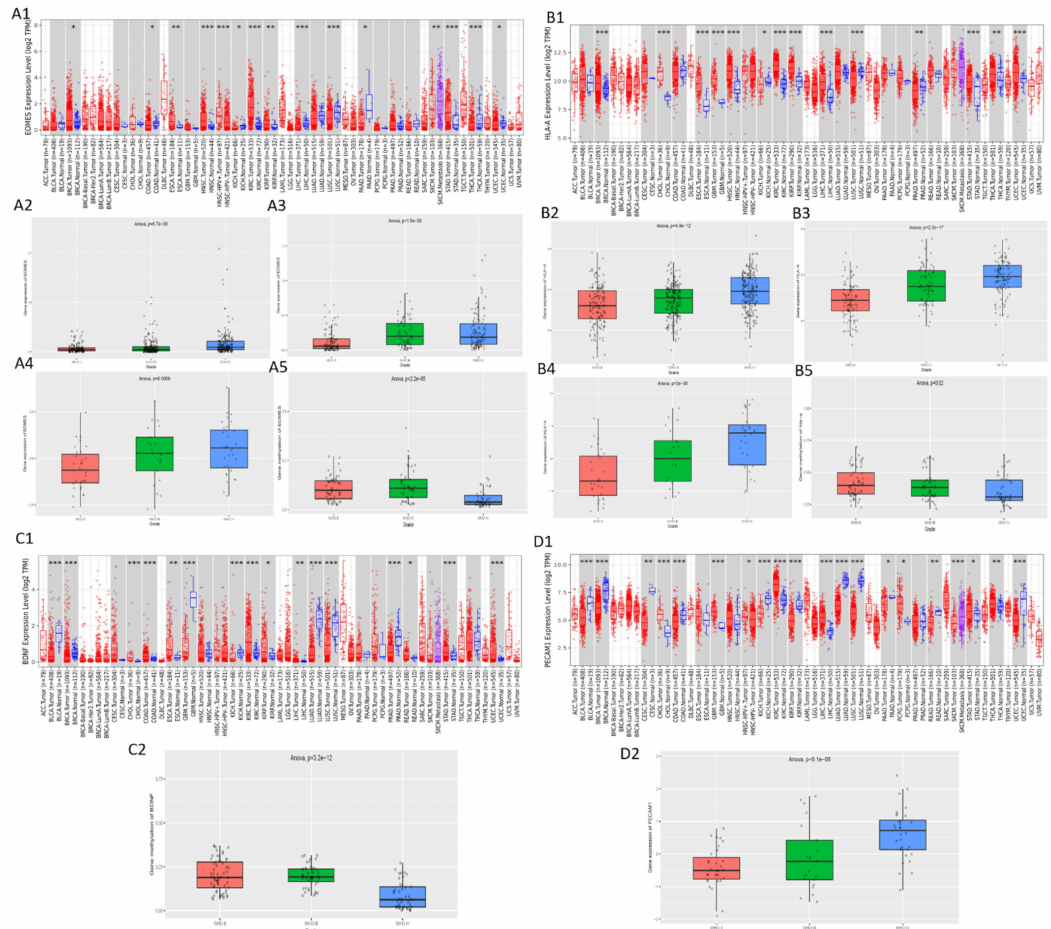
Figure 4. TCGA and CGGA expression profiles of EOMES, HLA-A, BDNF, and PECAM1. TCGA expression profiles of ( A1 ) EOMES, ( B1 ) HLA-A, ( C1 ) BDNF, and ( D1 ) PECAM1 in normal vs. tumor samples. CGGA expression profiles from mRNA seq ( n = 693) ( A2 ) EOMES and ( B2 ) HLA-A, mRNA seq ( n = 325) ( A3 ) EOMES and ( B3 ) HLA-A, mRNA-array ( n = 301) ( A4 ) EOEMS, ( B4 ) HLA-A and ( D2 ) PECAM1, and methylation ( n = 159) ( A5 ) EOMES, ( B5 ) HLA-A and ( C2 ) BDNF ((*: p -value < 0.05; **: p -value < 0.01; ***: p -value <